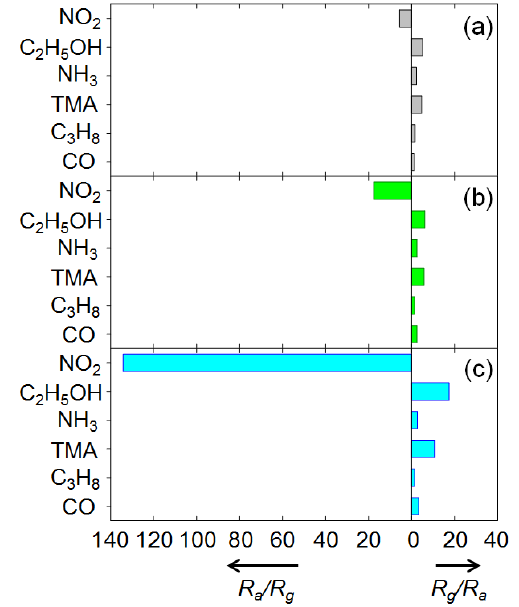
Figure 5. ( a ) Gas responses ( R ) of CuO, 0.76Cr-CuO, and 2.2Cr-CuO sensors to 100 ppm NO time ( τ recov 250–400